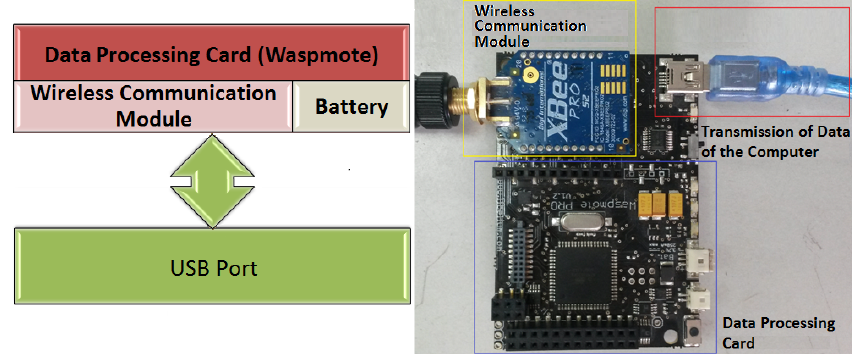
Figure 4. Structure of the coordinator nodes of the ZigBee and DigiMesh